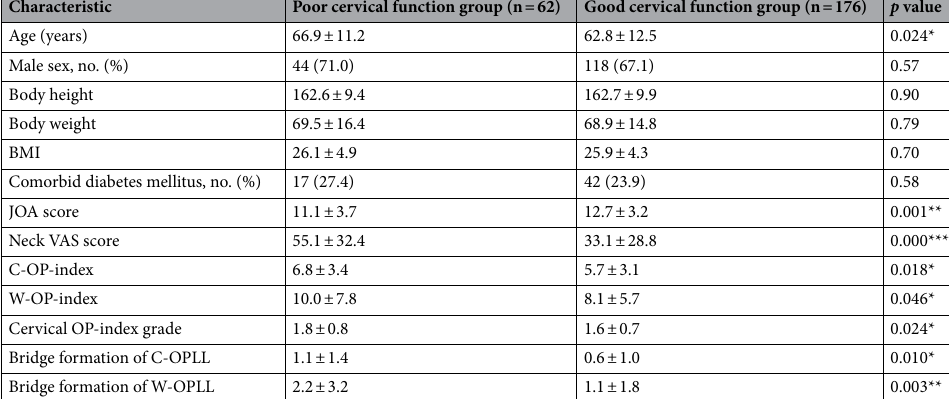
Table 4. Comparison between the groups with poor and good cervical function. Data are presented as mean ± standard deviation. BMI body mass index; JOA Japanese Orthopaedic Association; VAS visual analog scale (100-mm); C , cervical; W , whole spine; OP-index ossification index for OPLL; bridge formation ossified lesions forming a bridge with the posterior border of the adjacent vertebral body. * p < 0.05; ** p < 0.01; *** p <